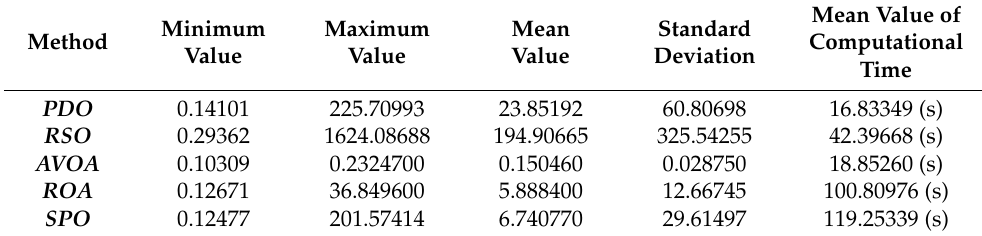
Table 8. Statistical analysis for proposed algorithms with case